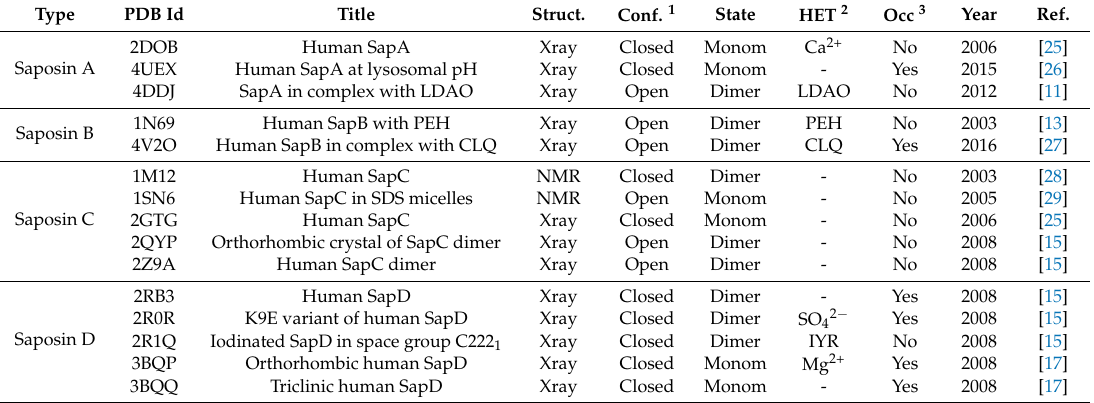
Table 1. Experimental structures of human saposins available in the PDB at 15 January